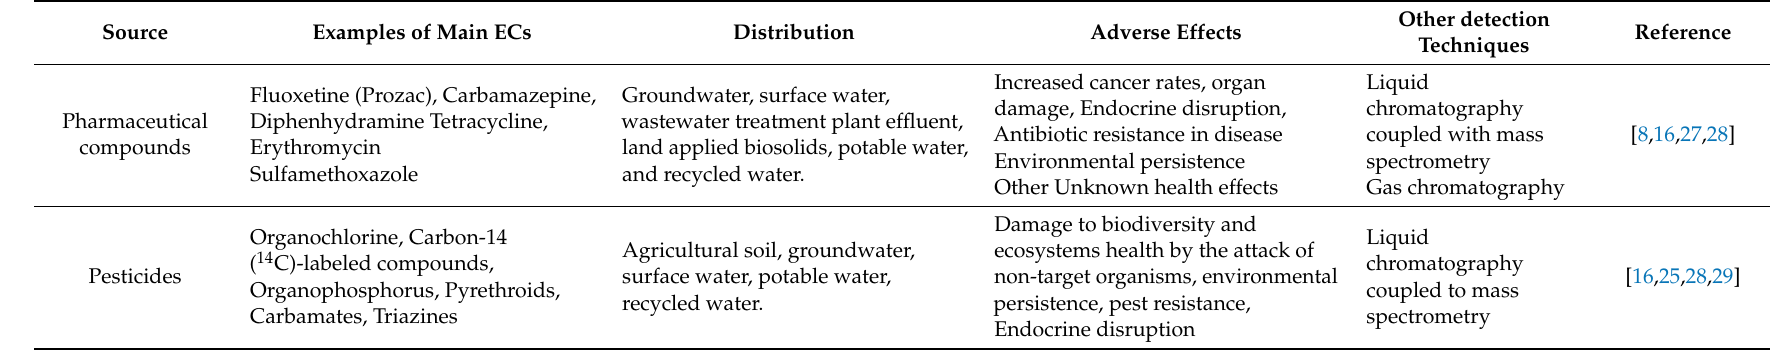
Table 1. Examples of EC categories derived from pharmaceutical compounds and pesticides, detection techniques, and associated effects on human health and the